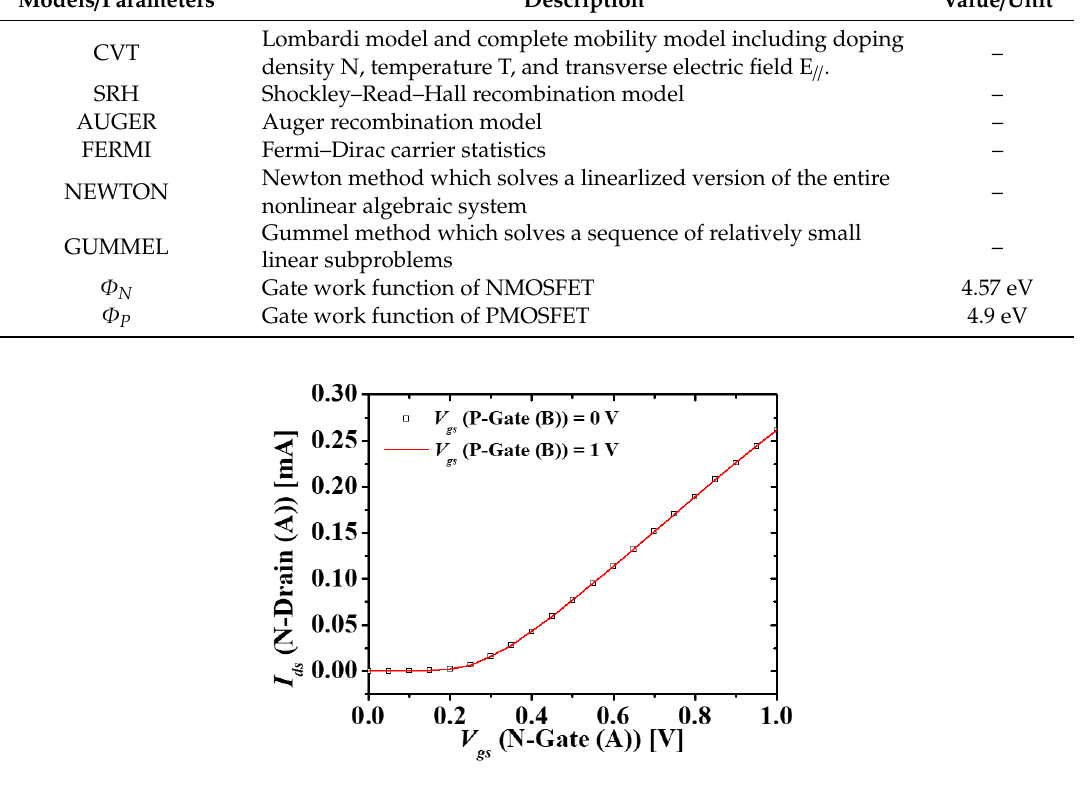
Figure 3. I ds - V gs characteristics of N-type (A) MOSFET when the gate voltage at P-type (B) MOSFET is 0 V and 1 0 V and 1 V.